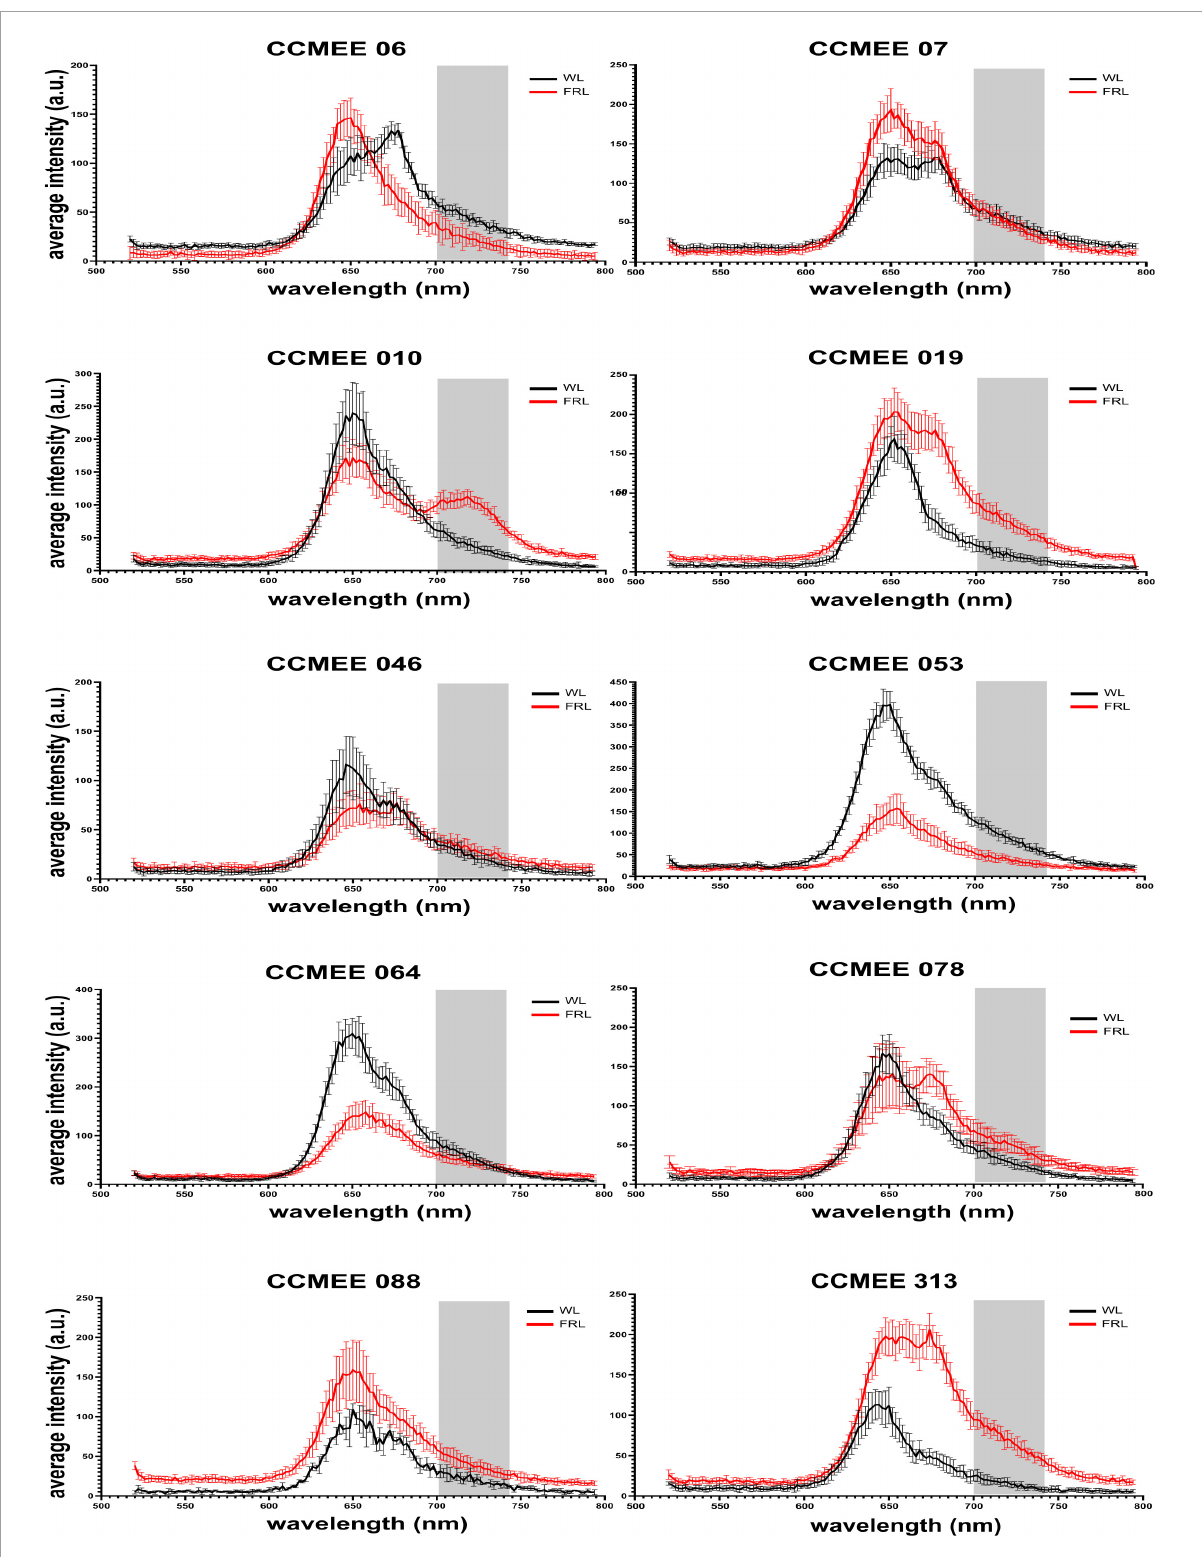
FIGURE2 CSLM spectral scans of individual cells of FaRLiP negative Chroococcidiopsis spp. CCMEE strains grown for 14 days under white or far-red